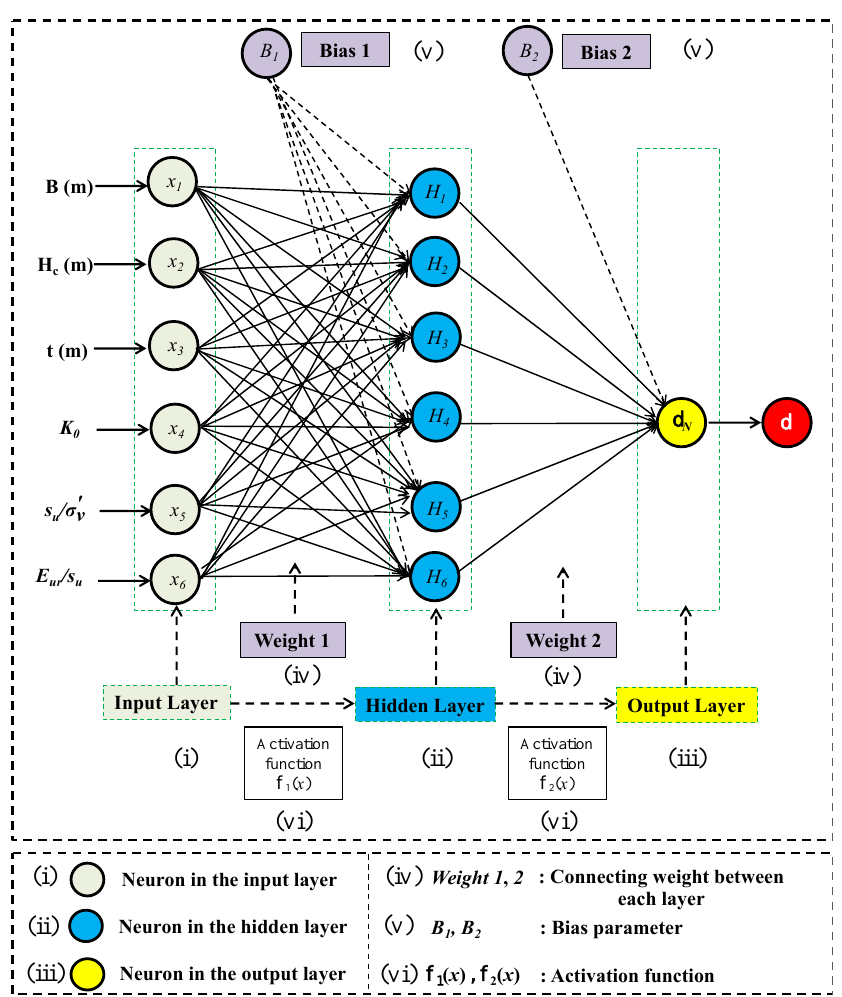
Figure 7. Architecture of the developed ANN model.